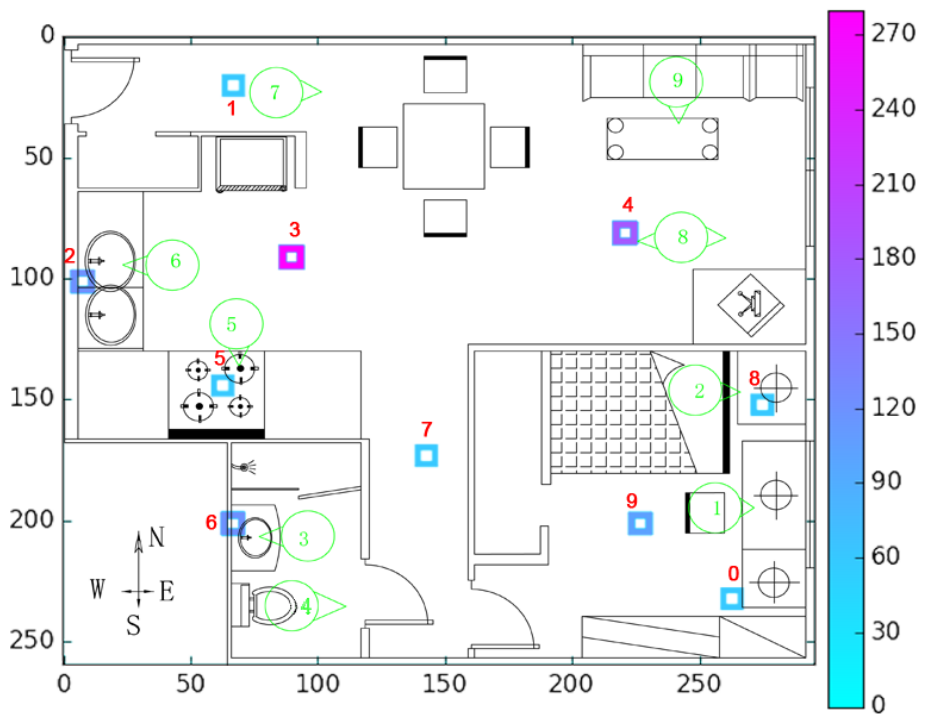
Figure 7. Floor layout and luminaire placement in one apartment. The numbered positions in green circles are KAAs, and the hollow squares are the luminaire with ID numbers, with different colors indicating the different luminous